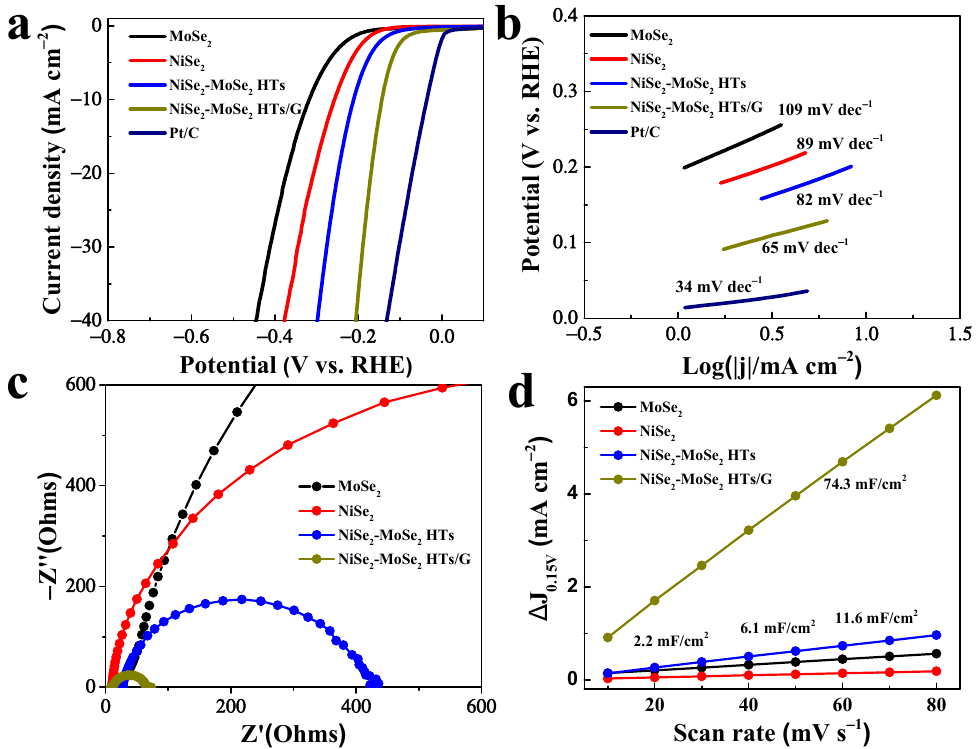
Figure 5. ( a ) Polarization curves of MoSe 2 , NiSe 2 , NiSe 2 -MoSe 2 HTs, NiSe 2 -MoSe 2 HTs/G, and Pt/C. ( b ) Tafel plots of MoSe 2 , NiSe 2 , NiSe 2 -MoSe 2 HTs, NiSe 2 -MoSe 2 HTs/G, and Pt/C. ( c ) EIS spectra of MoSe 2 , NiSe 2 , NiSe 2 -MoSe 2 HTs, and NiSe 2 -MoSe 2 HTs/G. ( d ) Estimated C dl of MoSe 2 , NiSe 2 , NiSe 2 -MoSe 2 HTs, and NiSe 2 -MoSe 2 HTs/G.